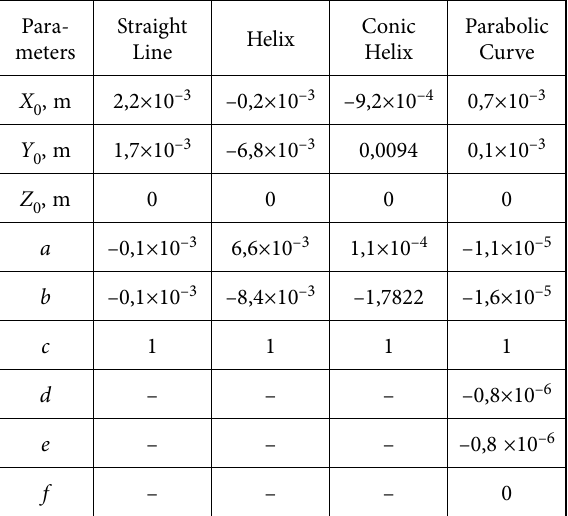
Table 3. Parameters of space curves